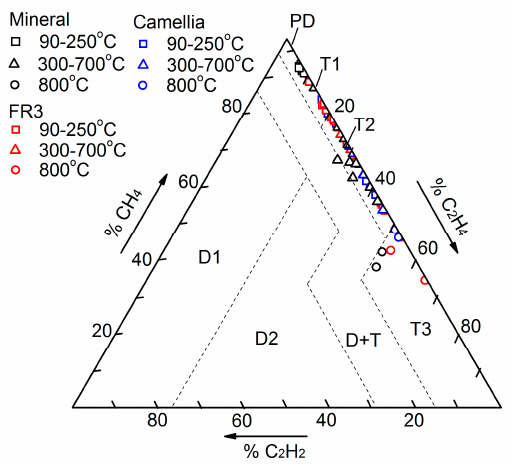
Figure 16. Diagnostic results of simulated thermal faults using Duval Triangle 1 (data in the figure are expressed as a function of oven temperature).